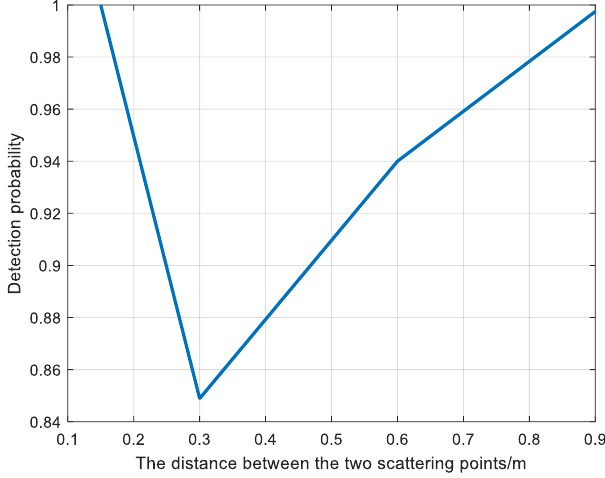
Figure 27. Detection probability diagram of two scattering points at different distances.